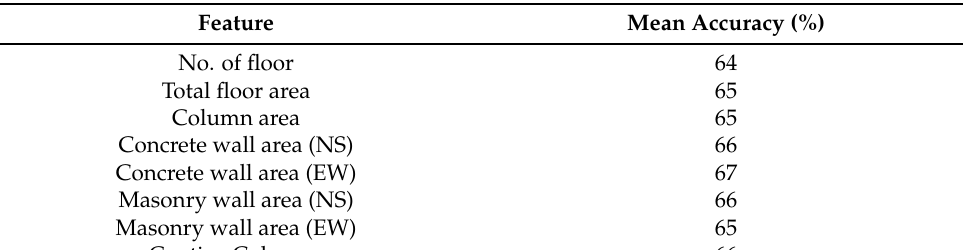
Table 4. Ecuador: Predictive accuracy score against each input feature.